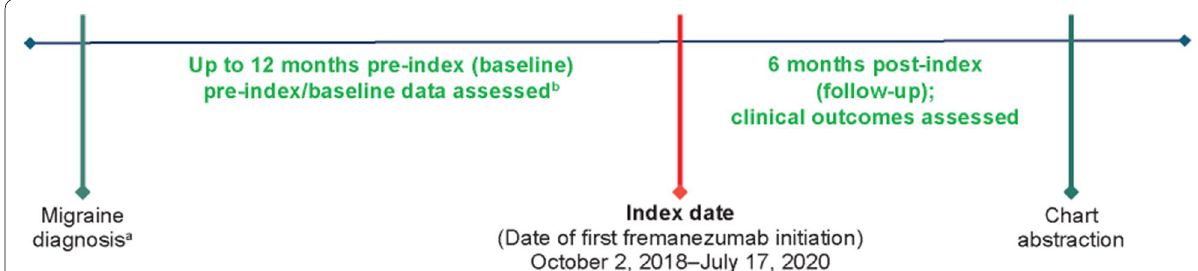
Fig. 1 Study design and dosing for patients with migraine. EM, episodic migraine; CM, chronic migraine; MMD, monthly migraine days; MHD, monthly headache days; HIT‑6, 6‑item Headache Impact Test; MIDAS, Migraine Disability Assessment. a Migraine diagnosis could have been established before 12 months pre‑index, but data were extracted as close to fremanezumab initiation as possible. b Baseline patient information (eg, comorbidities, prior treatments) were collected over 12 months pre‑index, while baseline clinical outcomes (eg, MMD, MHD, HIT‑6, MIDAS) were collected during the 3 months